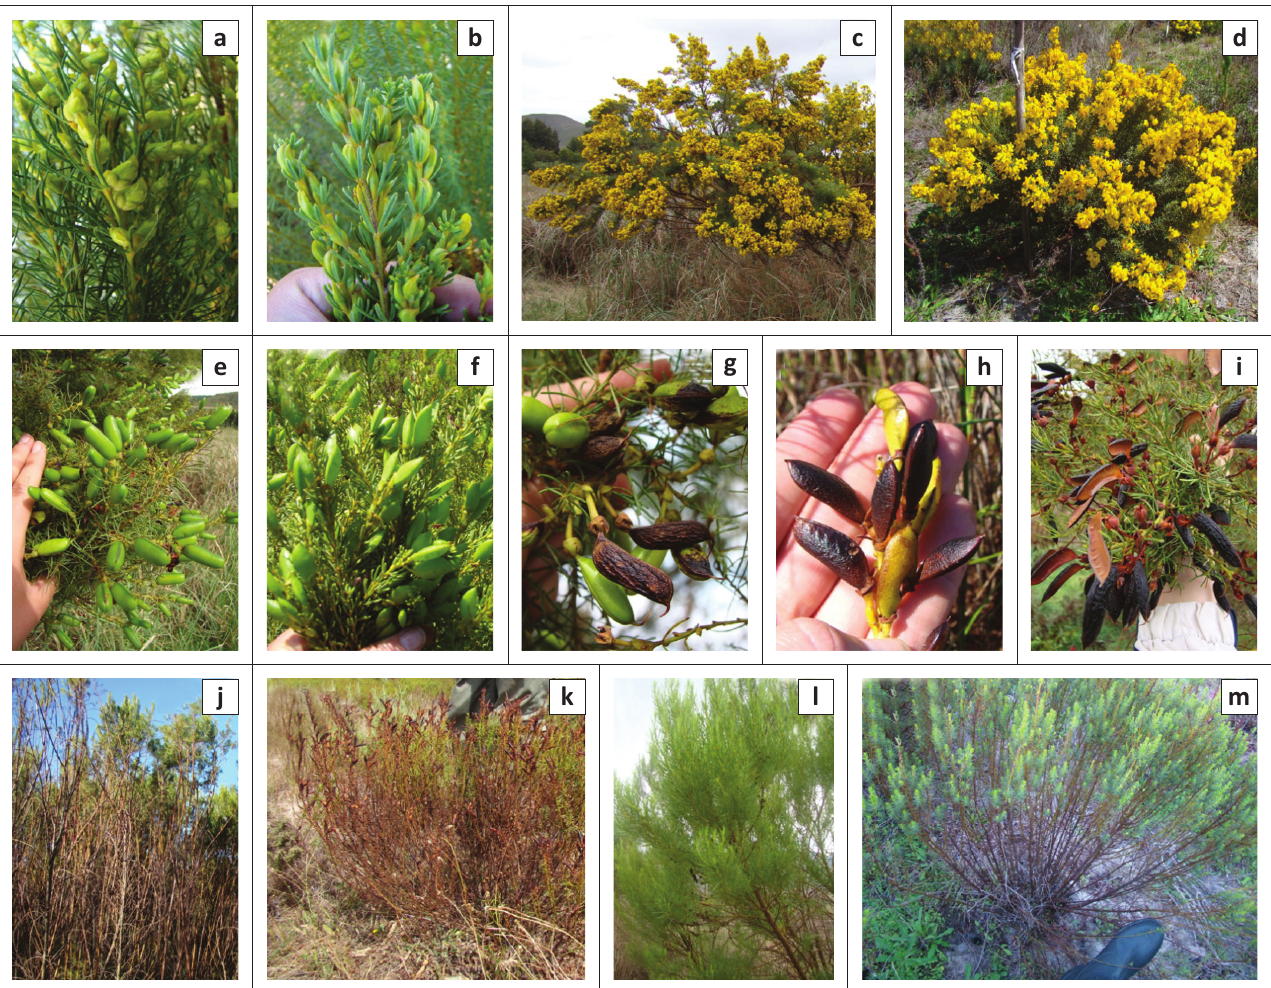
FIGURE 3: Phenology of Cyclopia maculata (2–3 m diameter × 1.5–3.0 m height) and C. genistoides (1.0–1.5 m diameter × ± 1 m height) (consistently to the left- and right-hand side, respectively): The reproductive phases of (a)-(b) floral budding (June–August), (c)-(d) peak bloom (October), (e)-(f) fruiting and (g)-(h) pod ripening (November), (i) seed release (picture of Cyclopia maculata ) and growth phases of (j)-(k) leaf shedding and new growth starting with a (l)-(m) summer flush. Observations were made from April 2014 to April 2015 at field sites in the Overberg, South